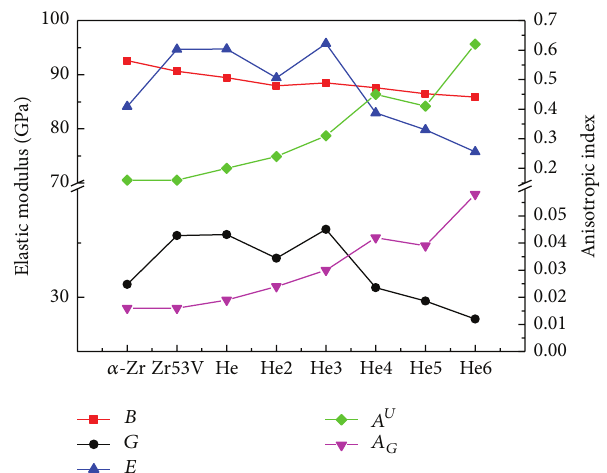
Figure 5: The elastic modulus ( B , G , and E ) and anisotropic index ( A U and 𝐴 𝐺 ) of 𝛼 -Zr and Zr-V-He systems calculated from Table 4 (He, He2 . . . represent Zr53VHe, Zr53VHe2 . . . , resp.).